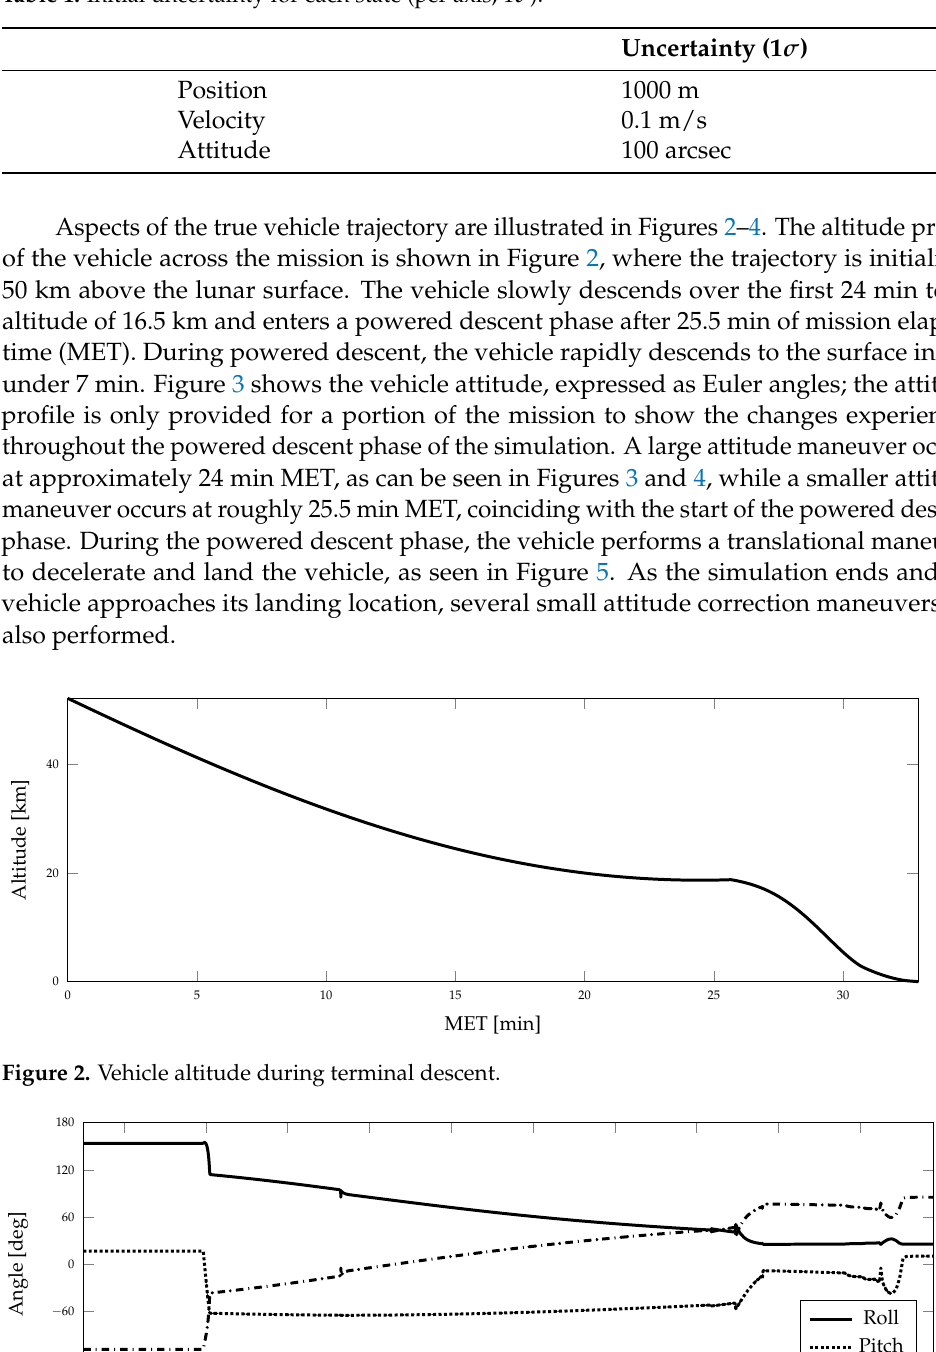
Table 1. Initial uncertainty for each state (per axis, 1 σ ).